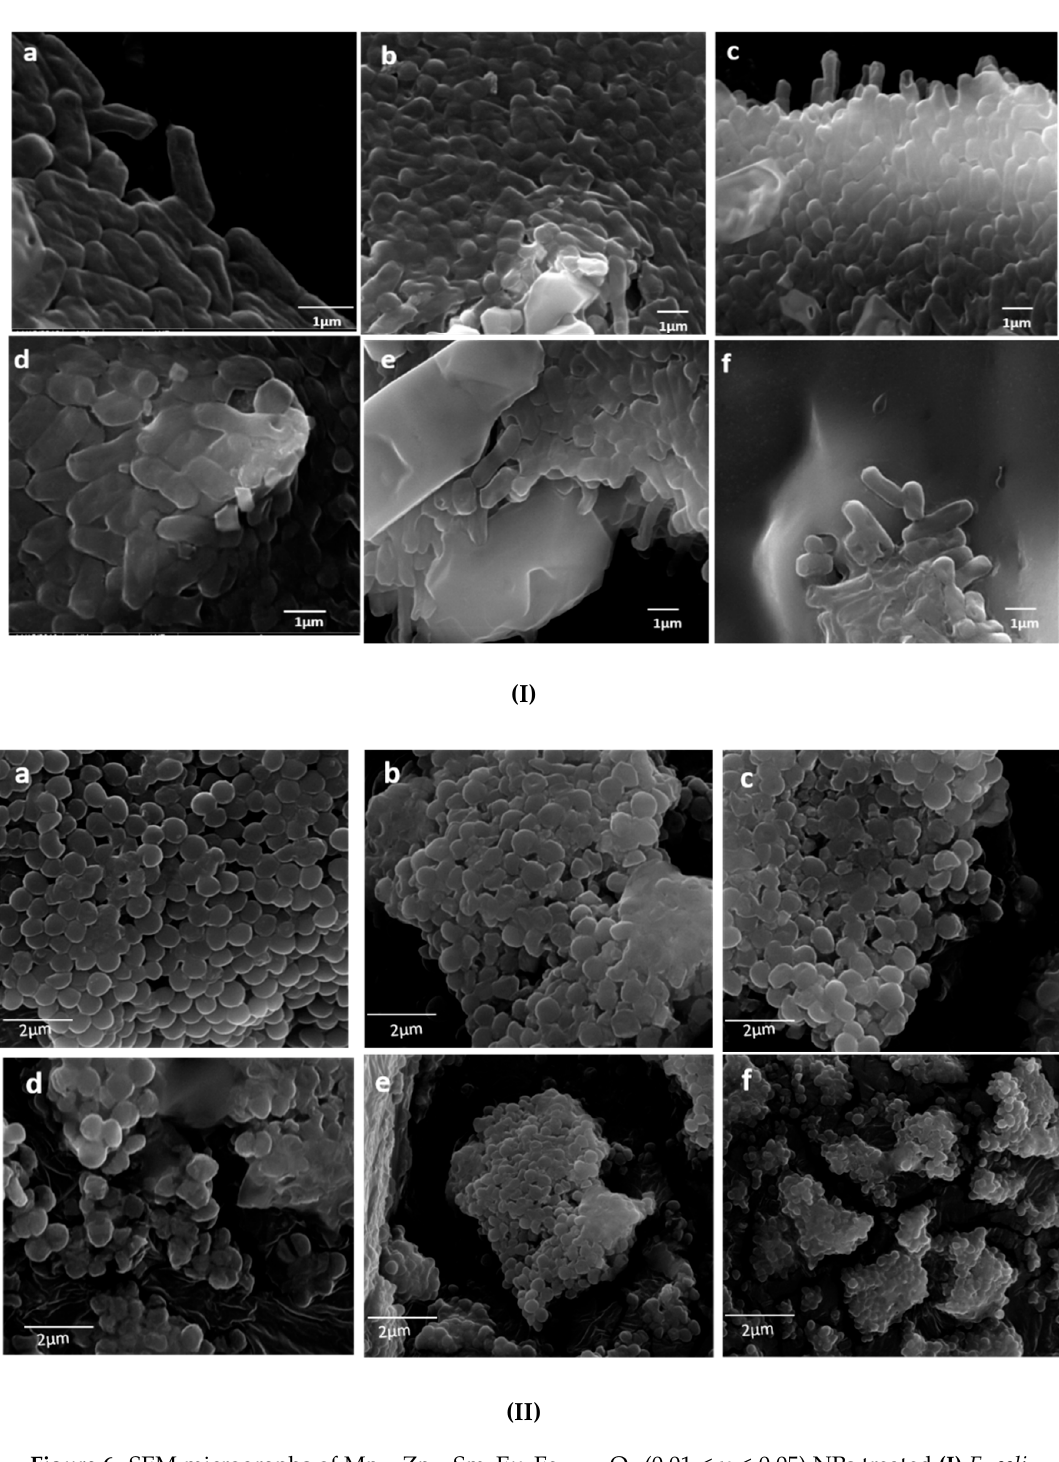
Figure 6. SEM micrographs of Mn 0.5 Zn 0.5 Sm x Eu x Fe 1.8 − 2x O 4 (0.01 ≤ x ≤ 0.05) NPs treated (I) E. coli , (II) S. aureus. ( a ) untreated cells (control), ( b ) x = 0.01, ( c ) 0.02, ( d ) 0.03, ( e ) 0.04, and ( f ) 0.05.